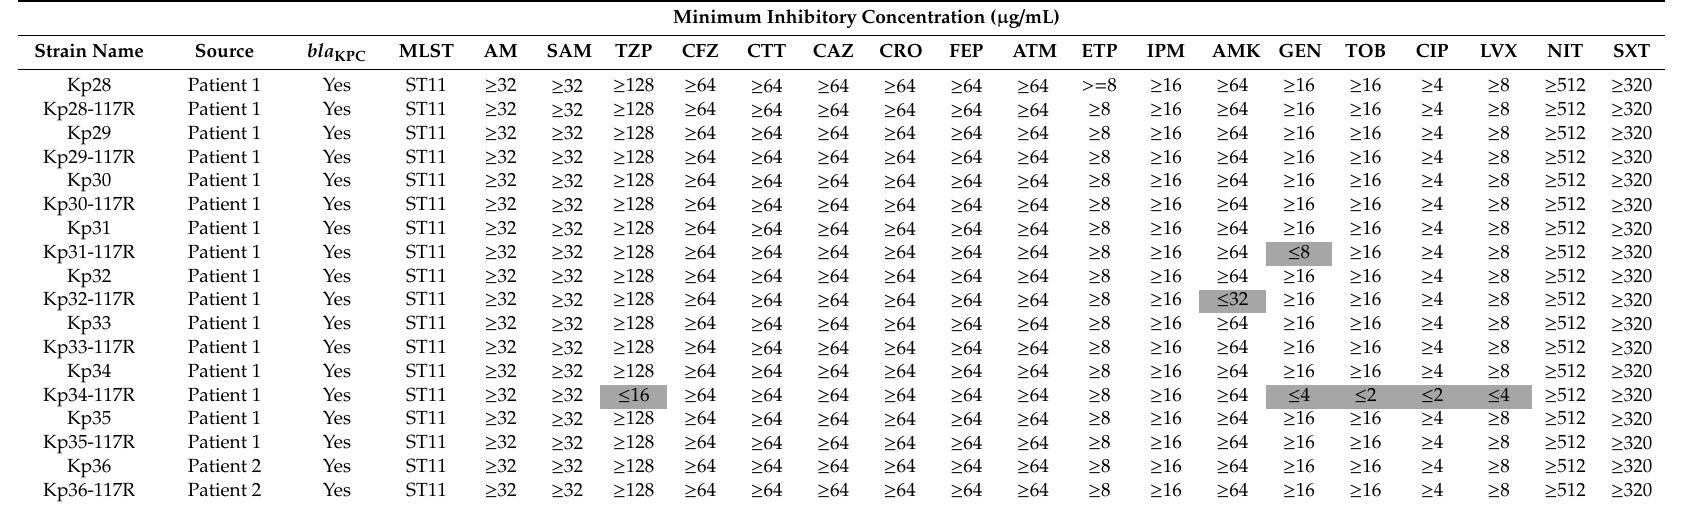
Table 1. Multilocus sequence typing (MLST) type and antibiotic resistance characteristics of K. pneumoniae strains and their corresponding phage-resistant mutants. Abbreviations for antibacterial agents: AM, ampicillin; SAM, ampicillin sulbactam; TZP, piperacillin tazobactam; CFZ, cefazolin; CTT, cefotetan; CAZ, ceftazidime; CRO, ceftriaxone; FEP, cefepime; ATM, aztreonam; ETP, ertapenem; IPM, imipenem; AMK, amikacin; GEN, gentamycin; TOB, tobramycin; CIP, ciprofloxacin;